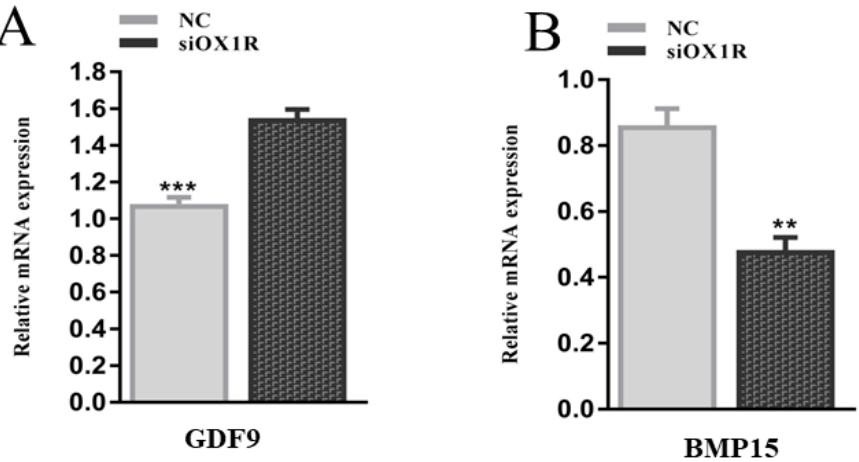
Figure 8. Effect of OX1R knockdown on the expression of oocyte-related genes in mouse GCs. ( A,B ) The mRNA expression of GDF9 and BMP15 was detected using RT-qPCR following siOX1R transfection for 48 h. The results are presented as the means ± SEM, and significant differences are indicated with error bars with asterisks (** p < 0.01, *** p < 0.001). NC, negative control; siOX1R, orexin receptor type 1 siRNA; OX1R, orexin receptor type 1; GC, granulosa cells; GDF9, growth differentiation factor 9; BMP15, bone morphogenetic protein 15.